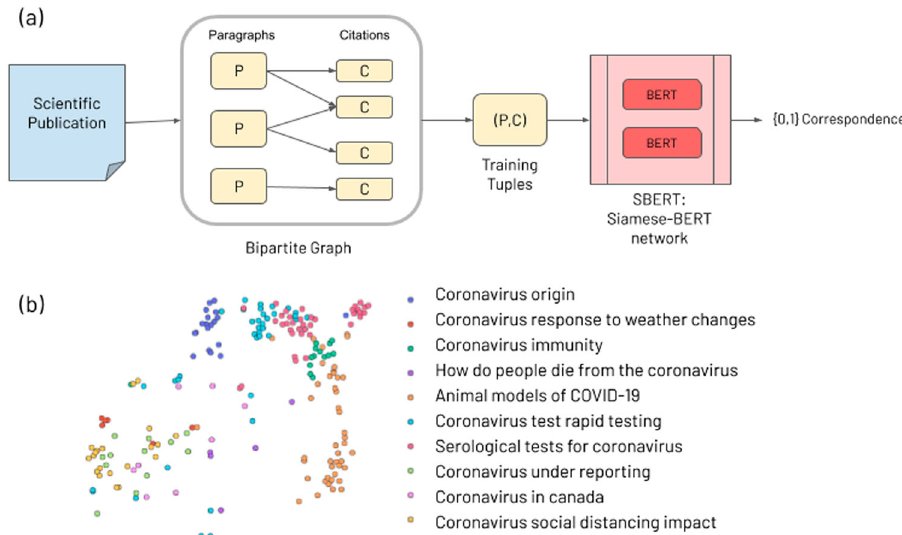
Fig. 1 Semantic search: learning to match queries to publication titles. a Documents are split into paragraphs and the citations included in them to form a bipartite graph that induces training tuples ( p , c ). These are fed to a Siamese-BERT (SBERT) model trained to discern if a citation is contained in a given paragraph. This process makes SBERT match user search queries to scienti fi c publication titles. b t-SNE visualization of the SBERT embeddings of entire documents, each denoted by a single point. Their color represents the topic to which they are most closely matched. Notably, queries pertaining to the same topic tend to cluster